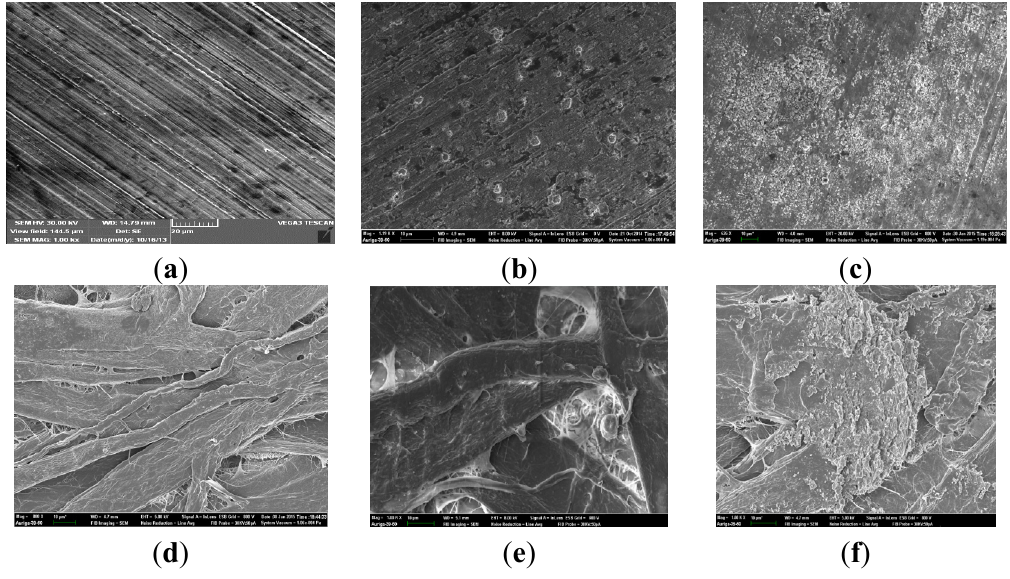
Figure 3. Scanning electron microscopy (SEM) of copper strip surface: ( a ) Sample I; ( b ) Sample II; ( c ) Sample III and paper surface: ( d ) Sample I; ( e ) Sample II; ( f ) Sample III.